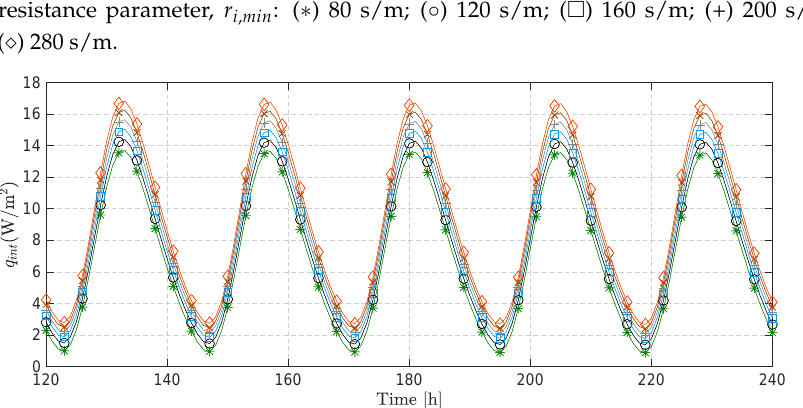
Figure 7. Heat flux distribution over time at the interior surface of the brick wall—sensitivity to minimum stomatal internal leaf resistance parameter, r i , min : ( ∗ ) 80 s/m; ( ◦ ) 120 s/m; ( (cid:3) ) 160 s/m; (+) 200 s/m; ( × ) 240 s/m; ( (cid:5) ) 280